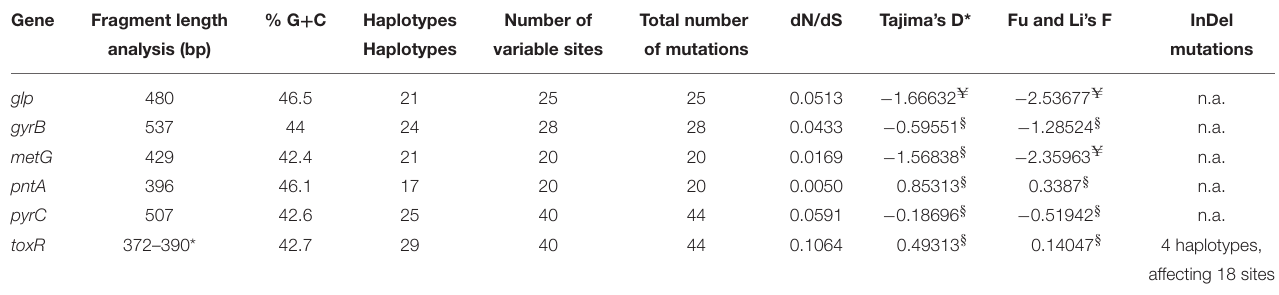
TABLE 2 | Genes used in the MLST scheme, including general description and statistical analysis. Gene Fragment length % G + C Haplotypes Number of Total number dN/dS Tajima’s D* Fu and Li’s F InDel analysis (bp) Haplotypes variable sites of mutations mutations